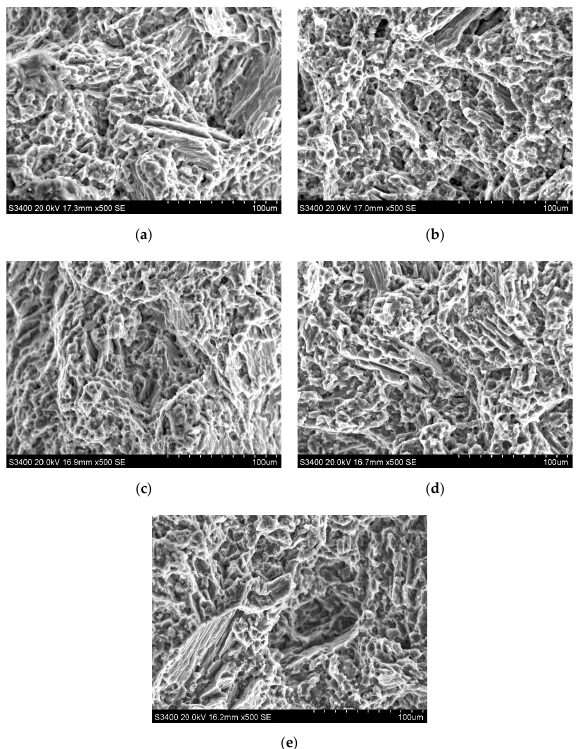
Figure 11. Tensile properties of welded joints and BM. ( a ) Tensile strength; ( b ) Elongation. Crystals 2022 , 12 , x FOR PEER REVIEW